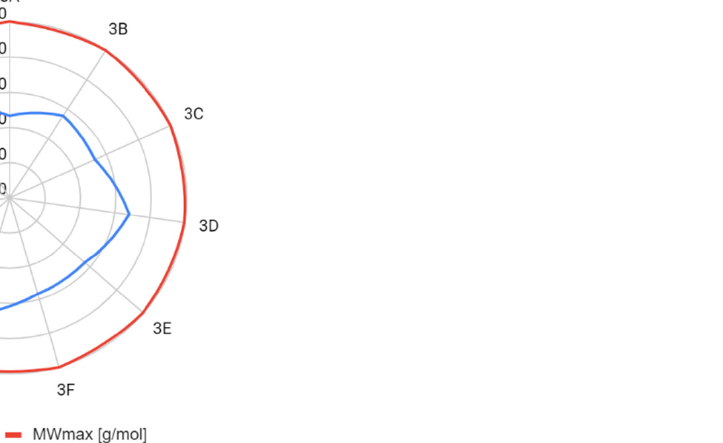
Figure 5. Comparison of the calculated lipophilicity values of the compounds tested (LogPmax— maximum logP value that satisfies Lipi ń ski’s rule).